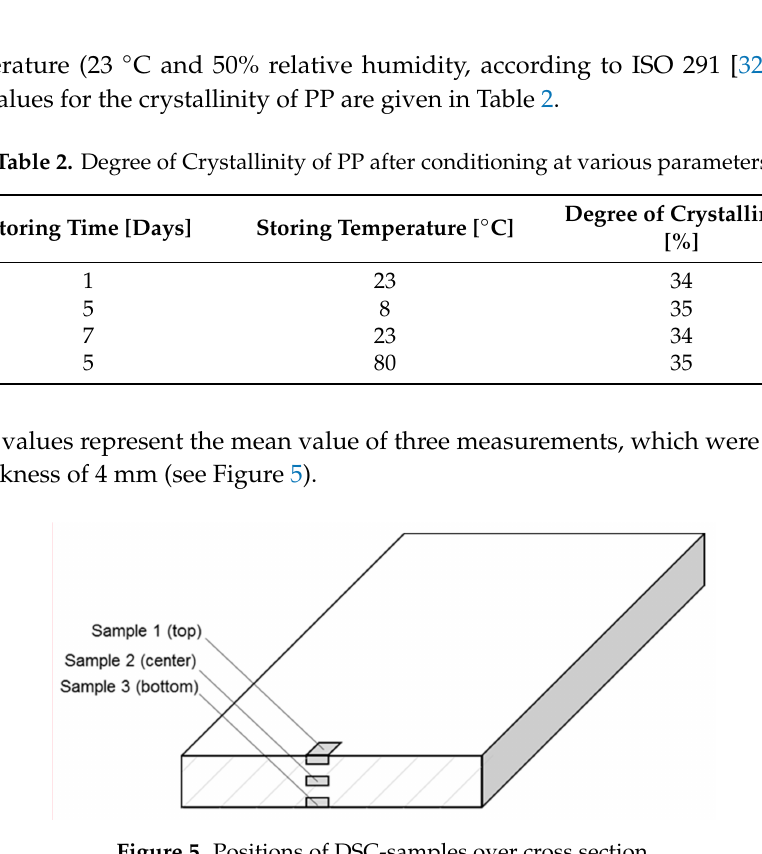
Figure 5. Positions of DSC-samples over cross